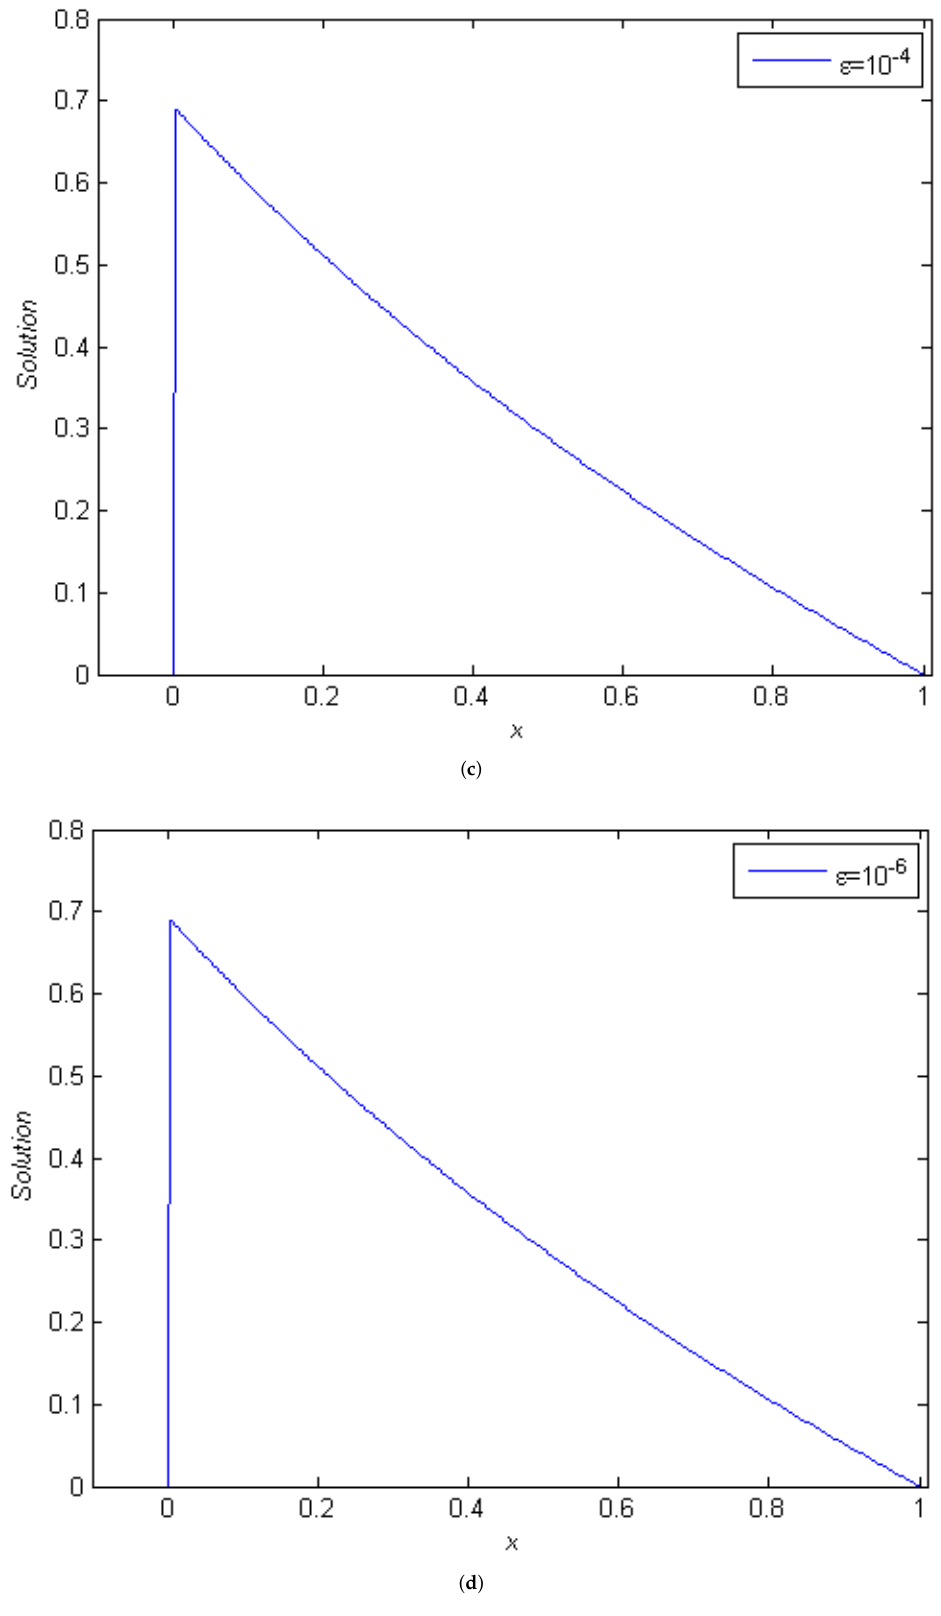
Figure 2. Plots of the approximate solution of Example 1 for ( a ) ε = 10 − 1 , ( b ) ε = 10 − 2 , ( c ) ε = 10 − 4 , and ( d ) ε = 10 − 6 with N =